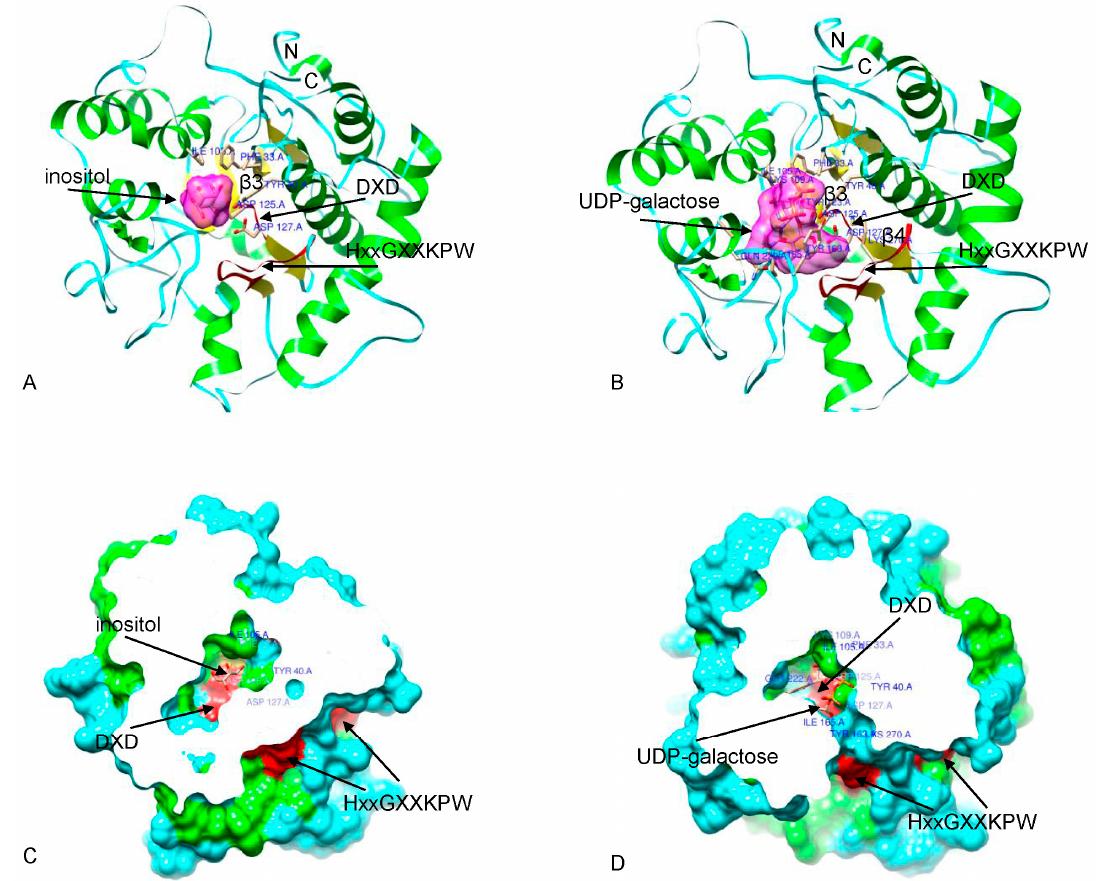
Figure 6. Docking of ligands onto the modeled BnGolS1-2 protein structure. ( A ) Docking results with inositol; ( B ) Docking results with UDP-galactose; ( C , D ) Surface representation of BnGolS1-2 showing that the ligands are buried deep in the binding pocket. In BnGolS1-2 proteins, the binding positions for UDP-galactose and inositol are close to the DxD motif. The inositol and UDP-galactose binding sites are represented in blue and the DXD and HxxGxxPW motifs are marked on the surface in red. Images were generated with Chimera 1.2.